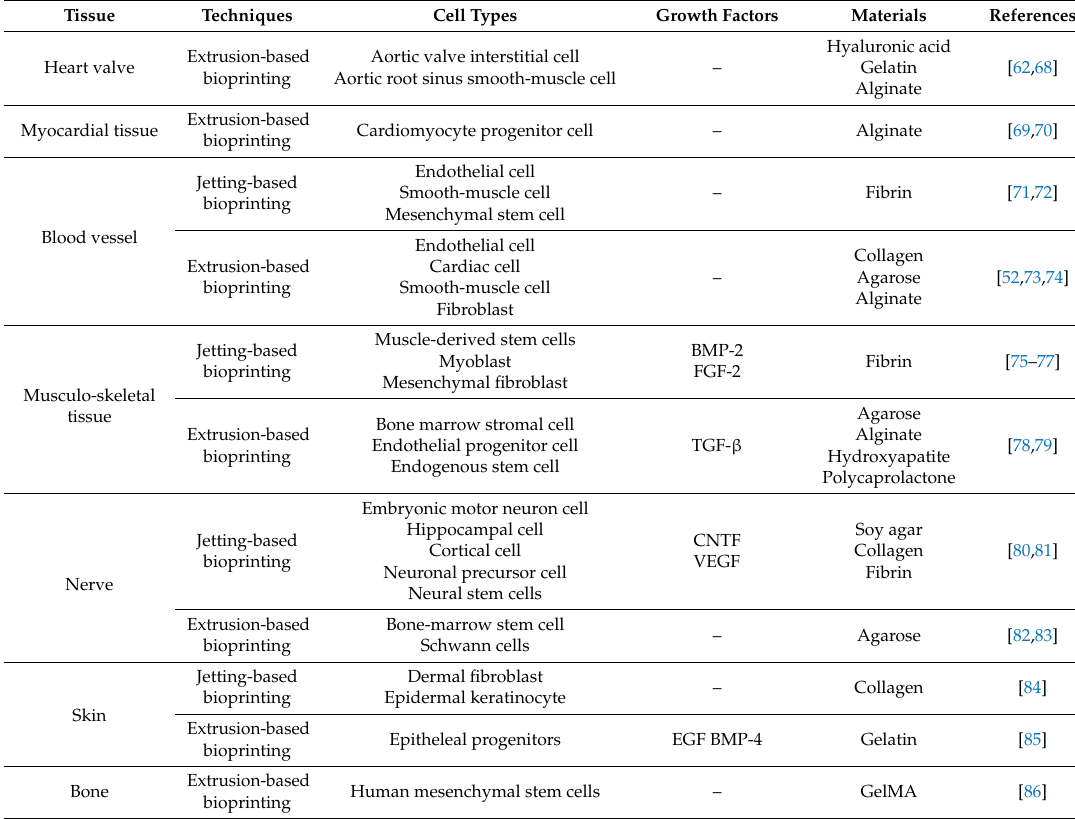
Table 5. Tissue-engineering applications using 3D bioprinting, adapted from Seol et al. [8]